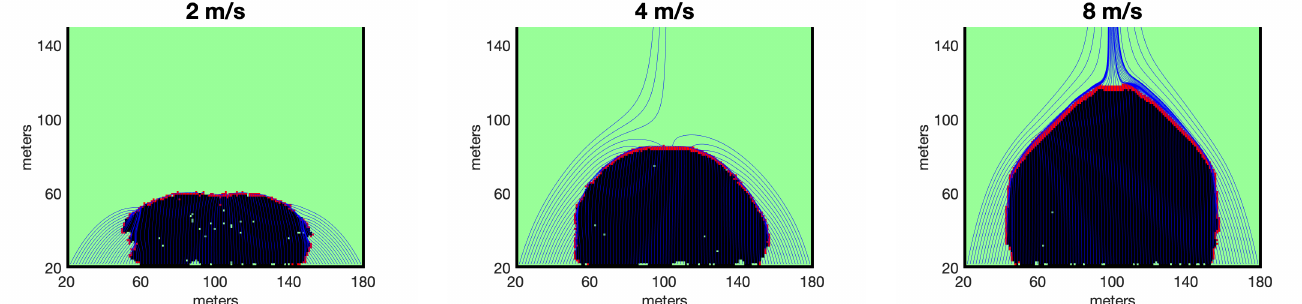
Figure 2. The streamlines and fire configuration at t = 48 s with three different background wind velocities. The sink and vorticity scales are reported in Table 1 and the burnout time is τ b = 15 s.